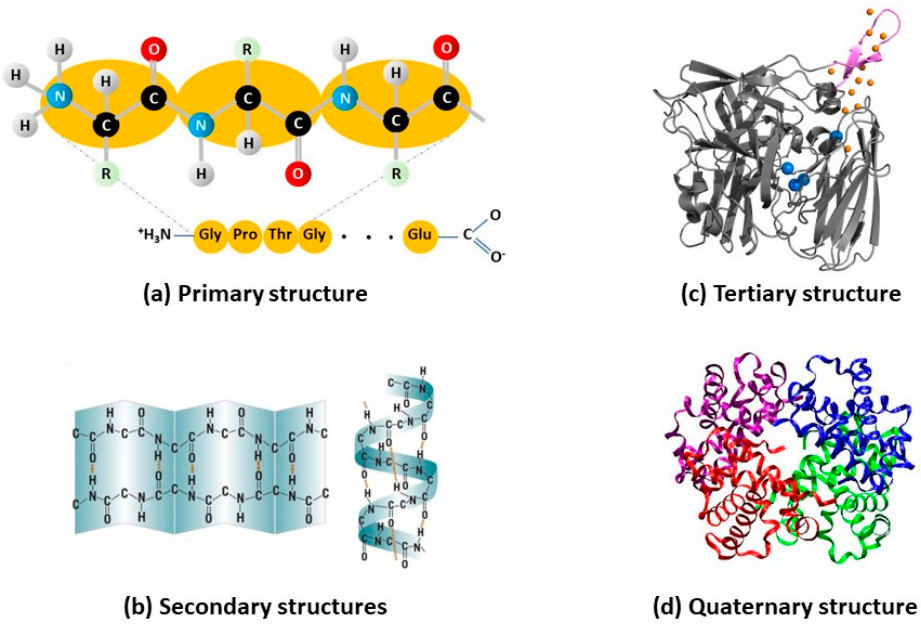
Figure 1. The four levels of protein structures determine the enzyme function.